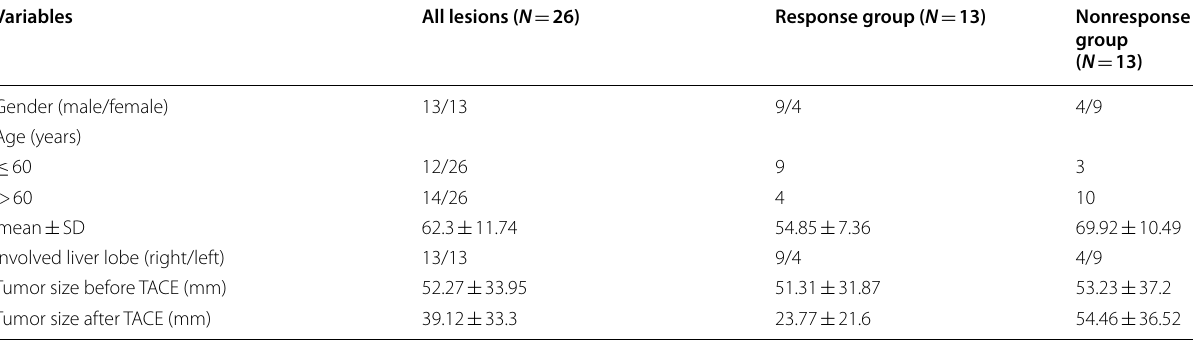
standard deviation ±